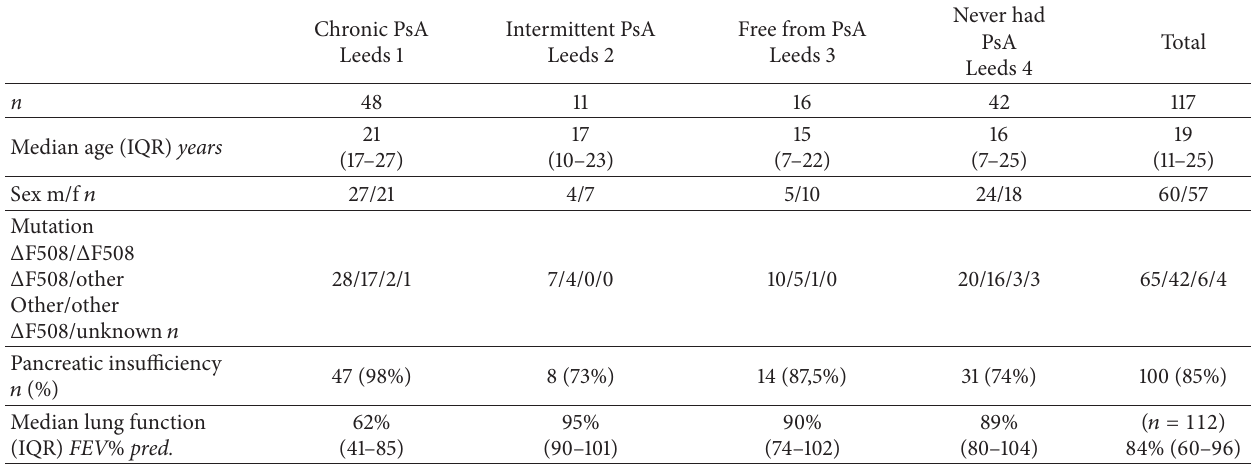
Table 1: Description of the cohort at